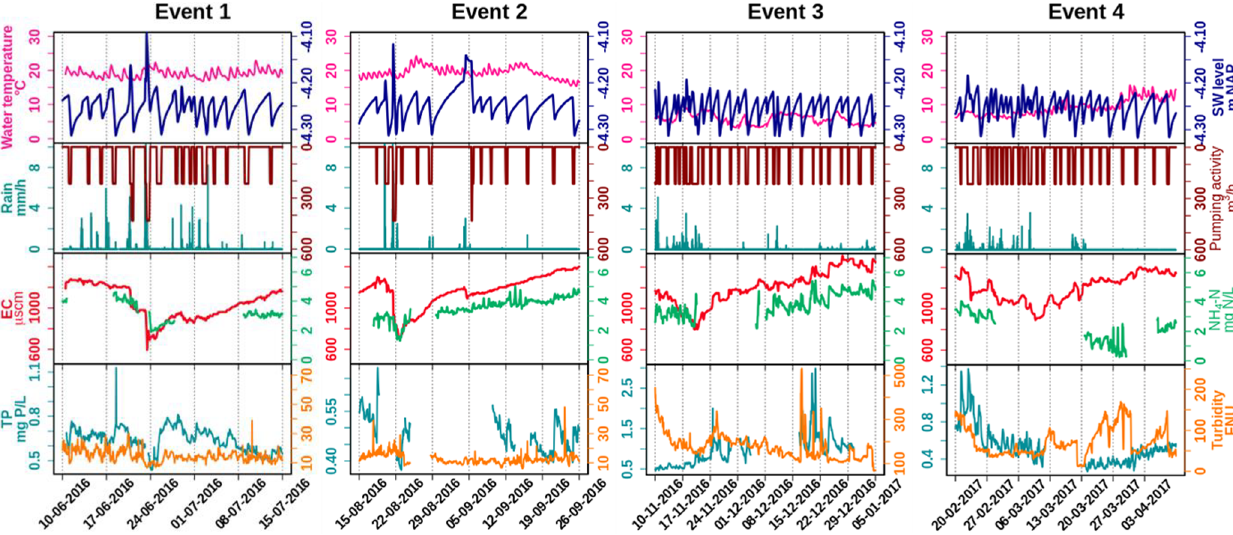
Figure 4. Selected events showing dilution and peaks of water quality parameters, with hourly precipitation (mmh − 1 ) and hourly pumping activity (m 3 h − 1 ). Note that between events different scales of TP and turbidity were used to reveal the dynamics. See Tables S7–S10 for the correlation tests performed on the